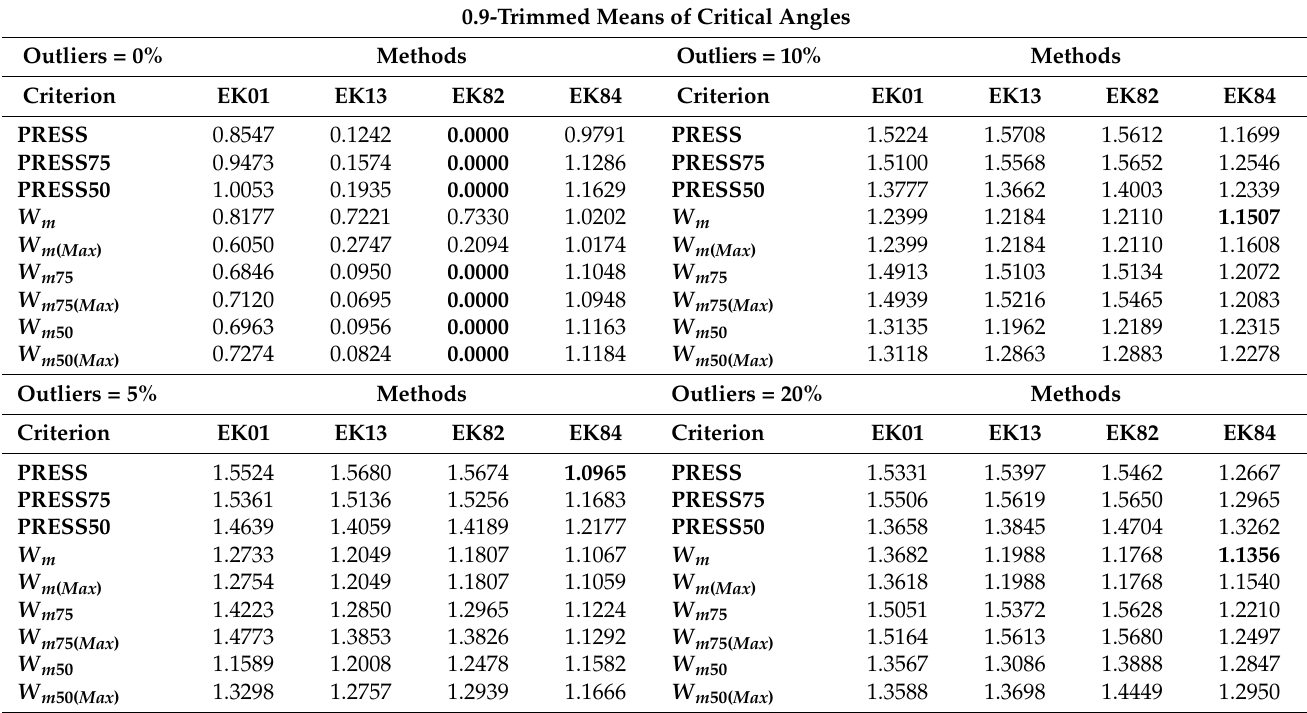
Table 2. The 0.9-trimmed means of critical angles in the simulation